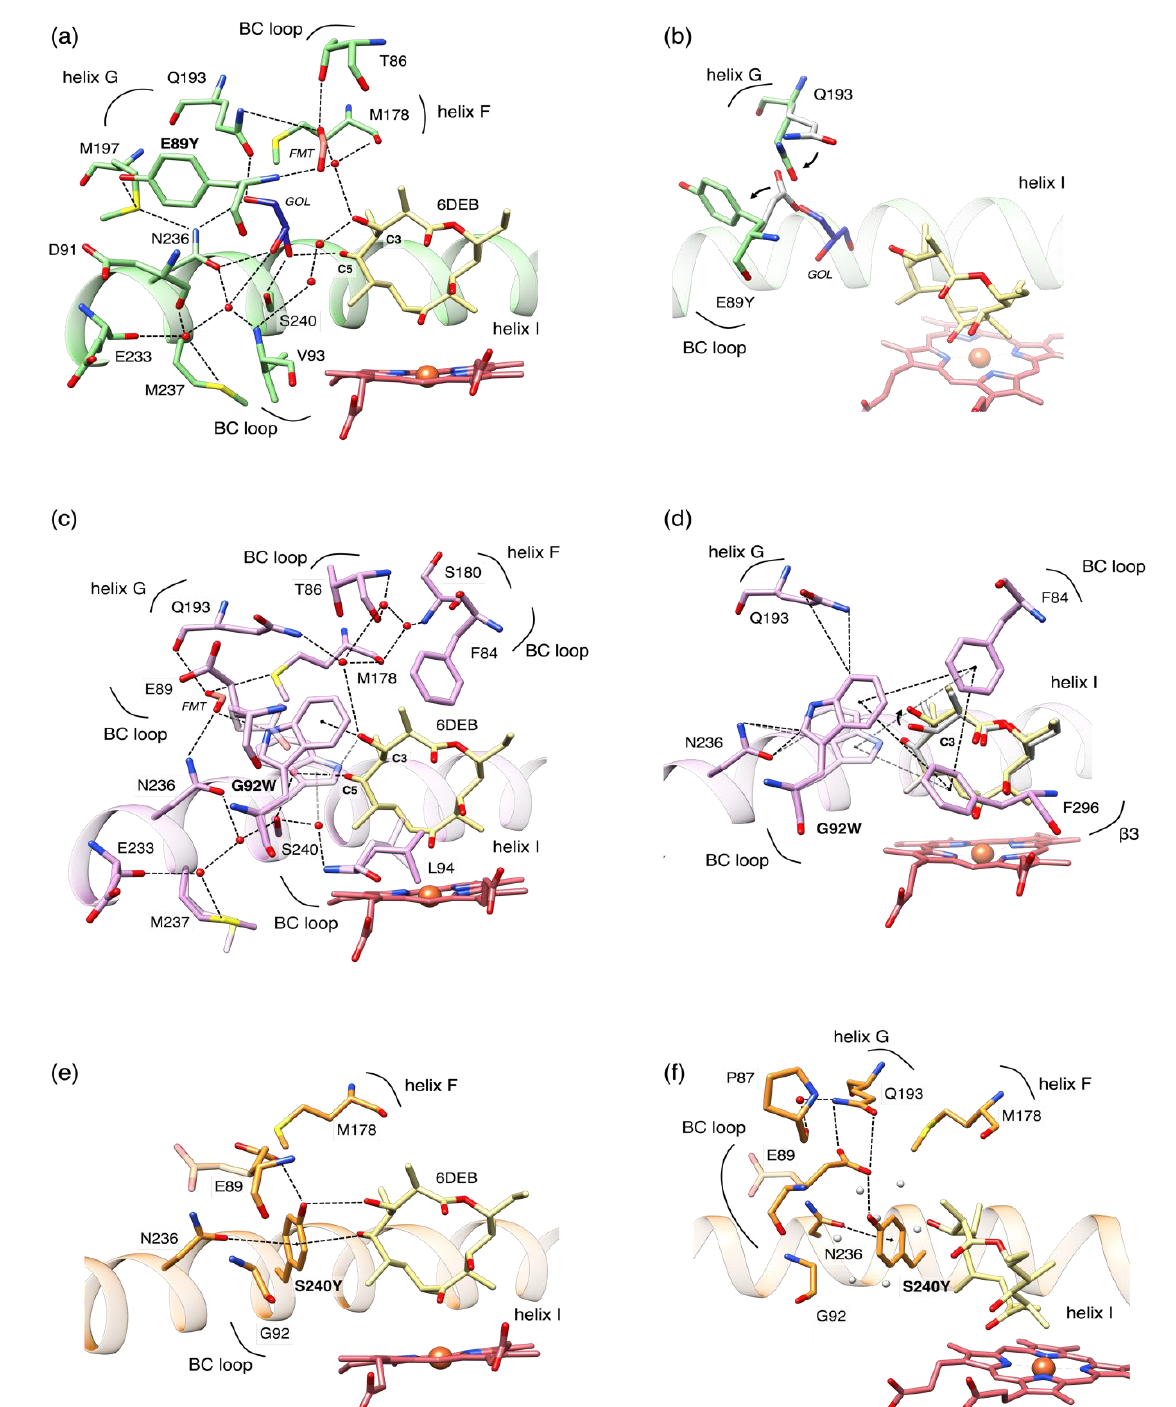
Figure 3. Structural changes in the solvent cavity of OleP mutants. Close up view of the changes in the solvent cavity induced by mutations at residues E89Y (panels ( a , b )), G92W (panels ( c , d )), S240Y (panels ( e , f )). Right panels show the cavity in the orientation that better renders the differences between the mutant and wild type. Residues involved in contacts within 4 Å of distance are shown as sticks and labelled. Dashed lines indicate hydrogen bonds or π -interactions. Double conformations are reported, showing the less occupied conformer in transparency. Solvent molecules of glycerol (GOL) and formate ion (FMT) are labelled in italic. Heme and 6DEB are represented as red and khaki sticks, respectively; waters found in the structure of mutants are in red spheres, while those found in the wild type structure are in white spheres.